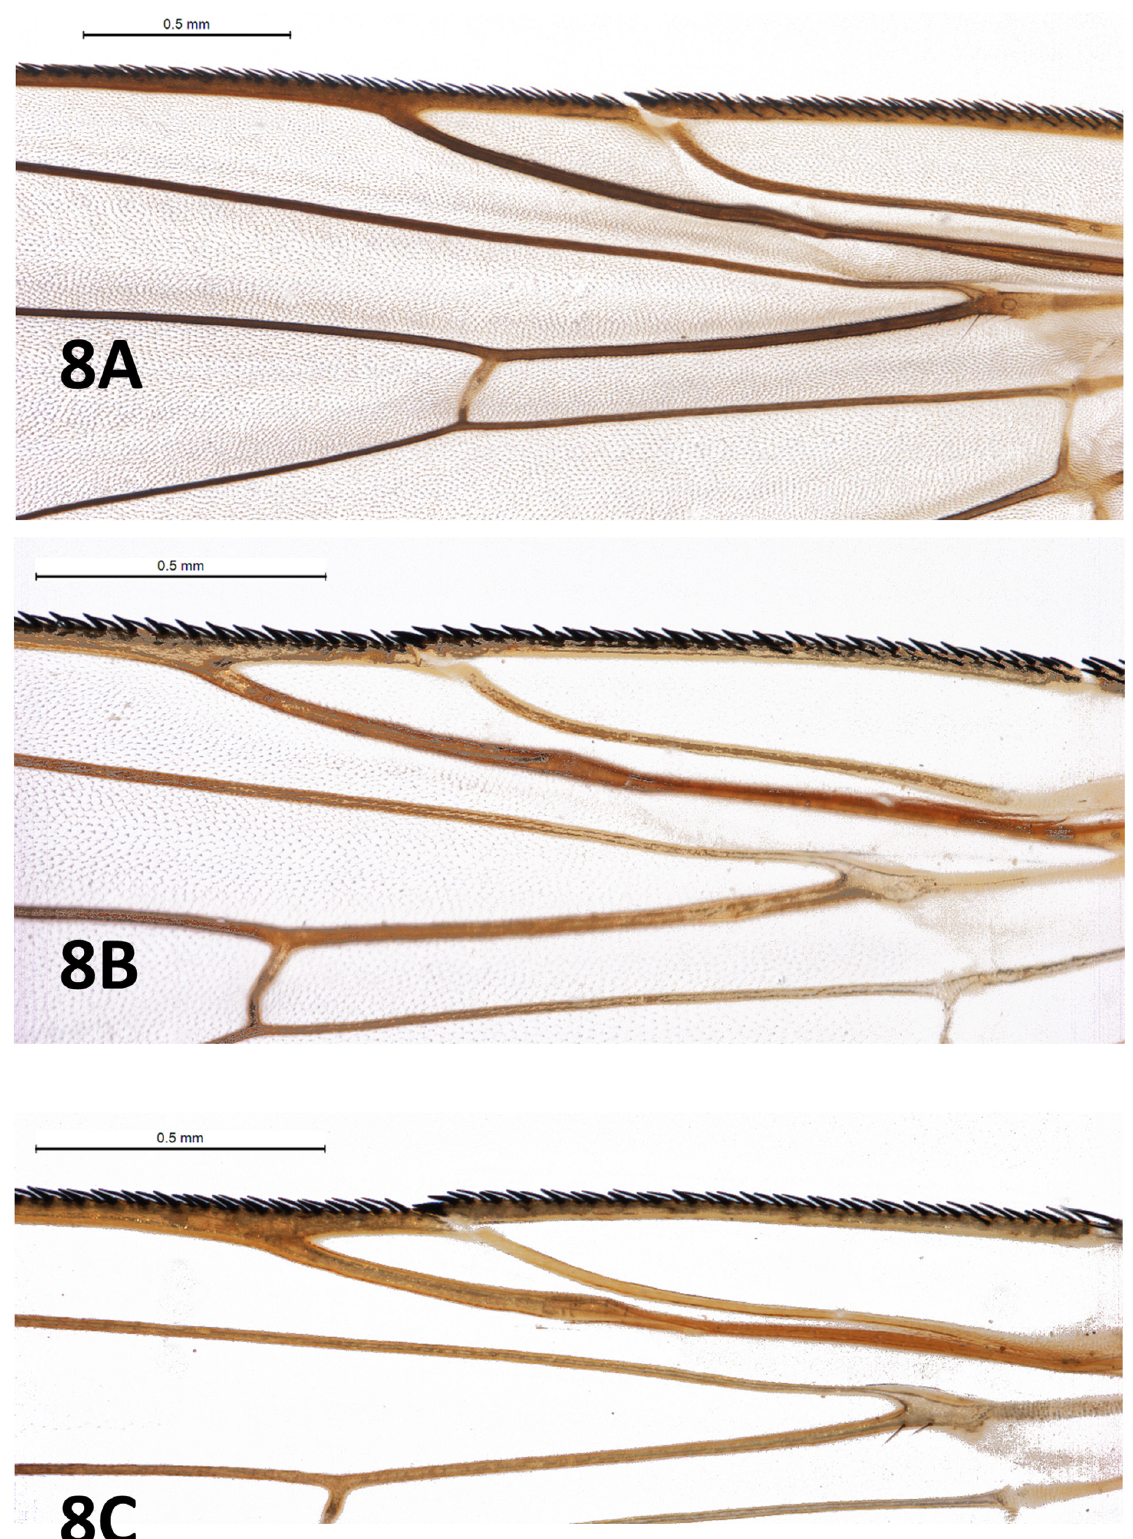
Fig. 8. ♀♀ of Musca Linnaeus, 1758. A . M . domestica Linnaeus, 1758, detail of wing showing CS1‒3, ventral view. B . M . sorbens Wiedemann, 1830, detail of wing showing CS1‒3, ventral view. C . M . vitripennis Meigen, 1826, detail of wing showing CS1‒3, ventral 112